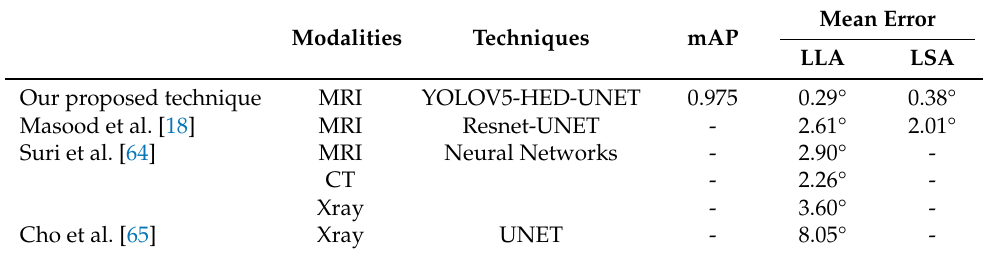
Table 8. LLA and LSA mean errors for our proposed technique are 0.29° and 0.38°, respectively, while [18] has mean errors of 2.61° and 2.01° for LLA and LSA. The first two techniques are applied on the same dataset. Cho et al. [65] and Suri et al. [64] have relatively larger LLA mean